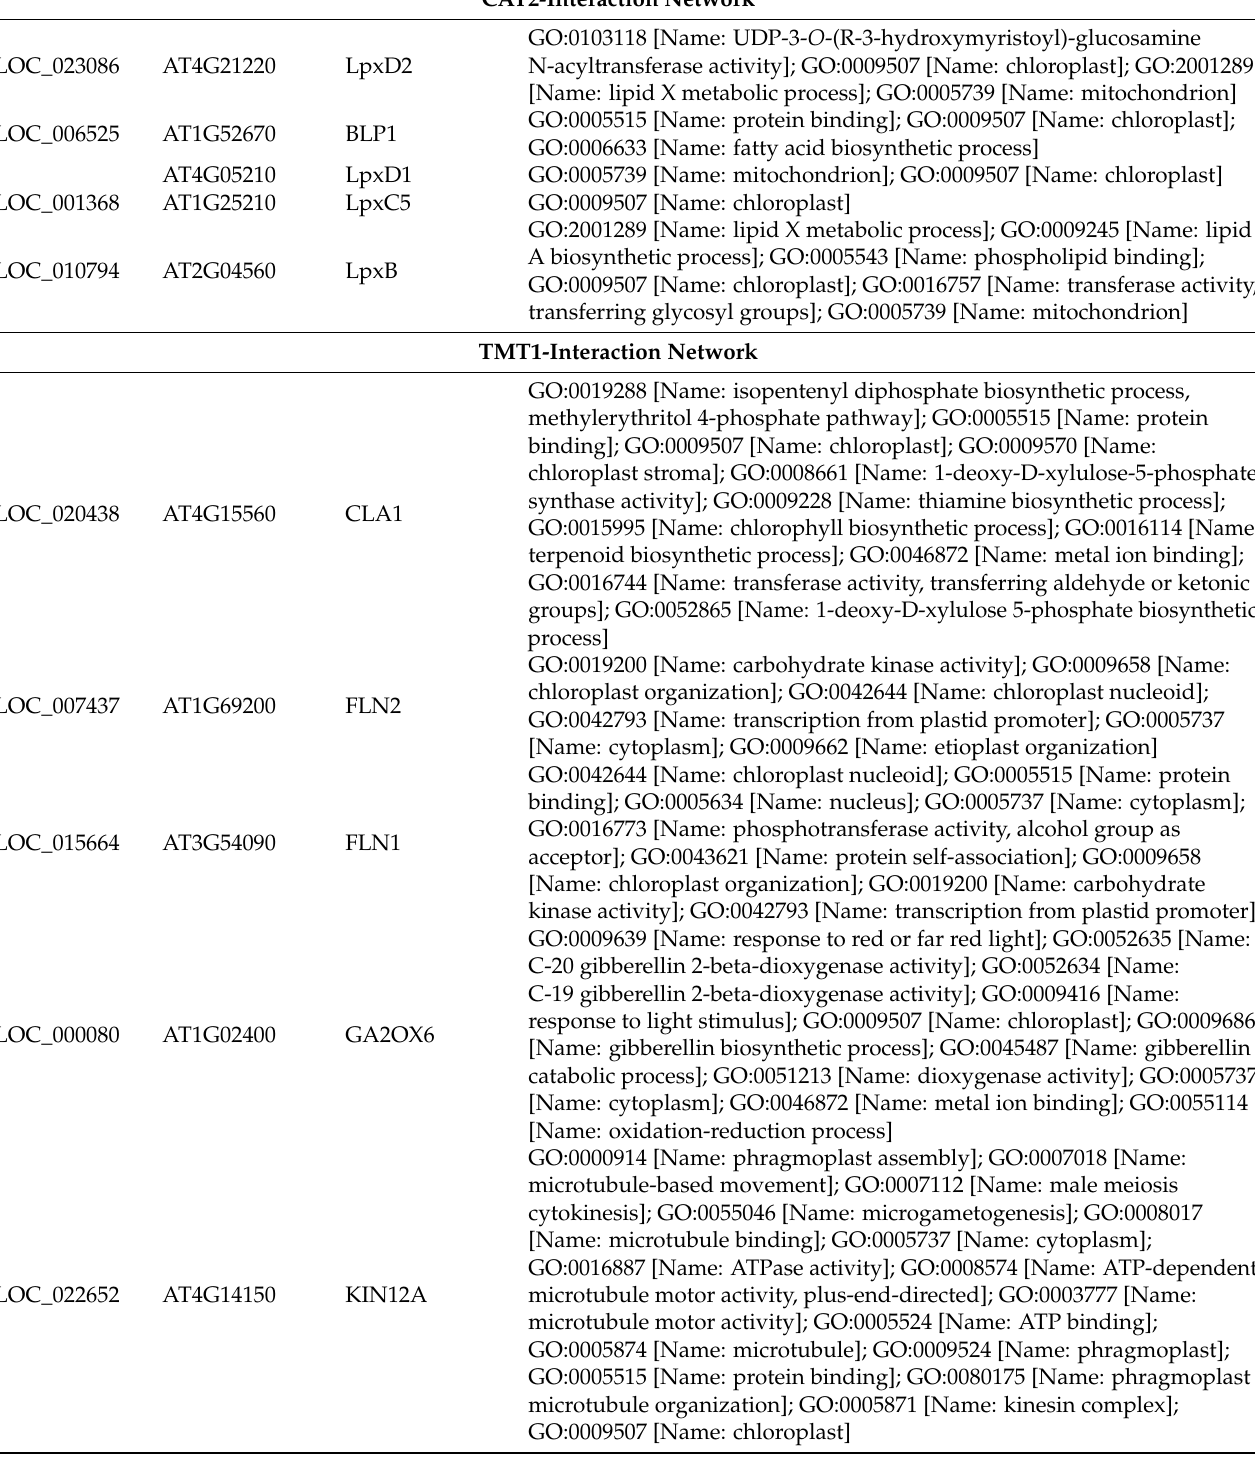
Table 2. GO information for CAT2 and TMT1-interacting proteins. CAT2-Interaction